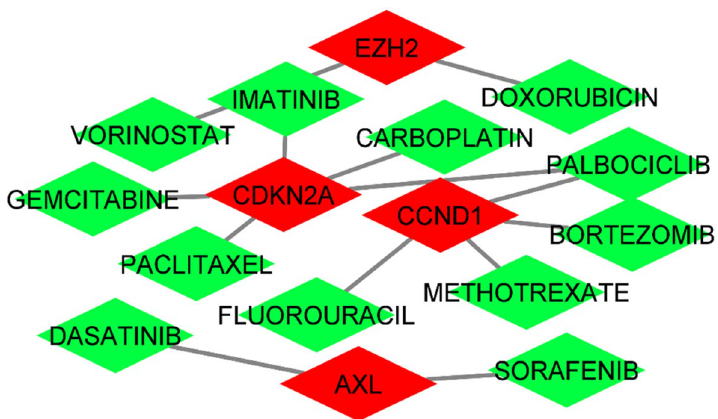
Fig. 7 Drug–hub gene